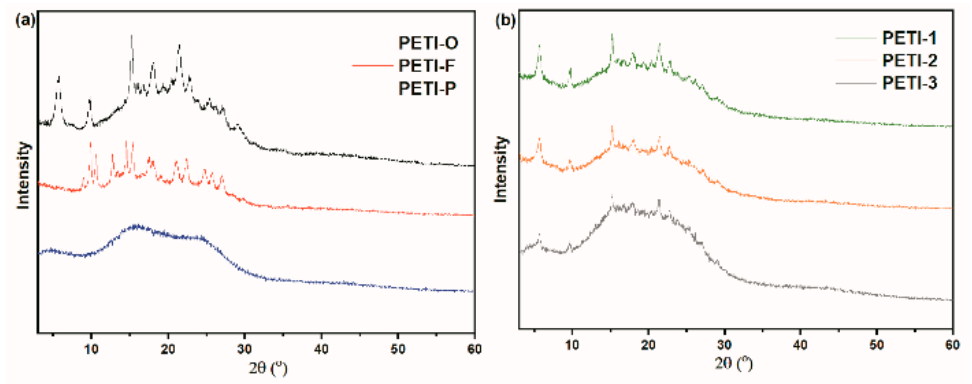
Figure 4. Wide angle X-ray diffraction patterns of ( a ) PETI-O, PETI-F, PETI-P and ( b ) PETI-1, PETI-2, PETI-3.